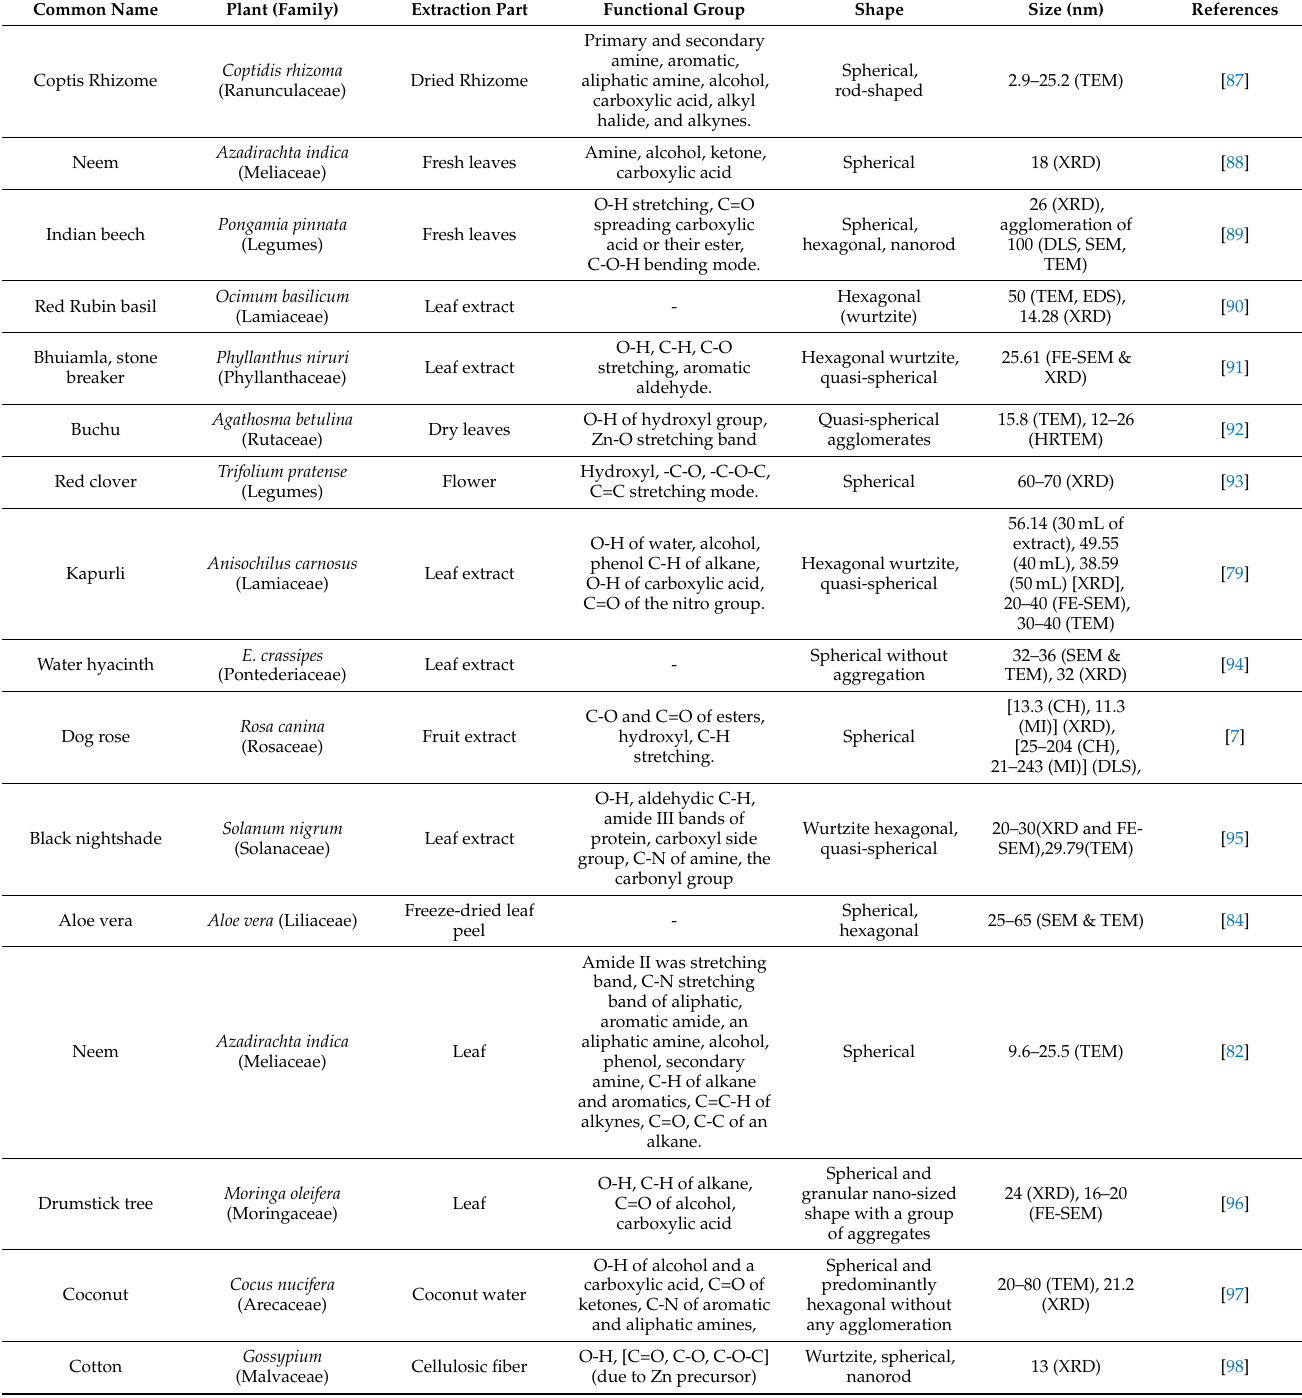
Table 1. ZnO-NPs synthesized using a plant-mediated